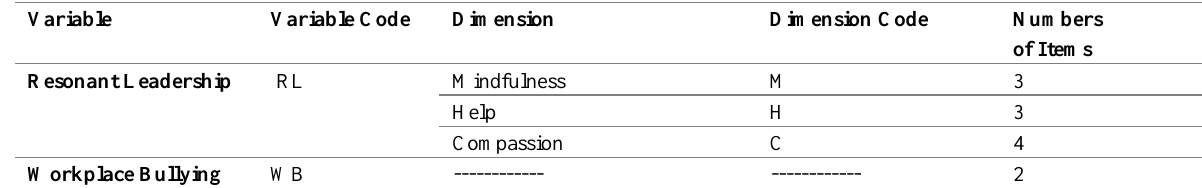
Table 4: Coding of Variables, Dimensions and